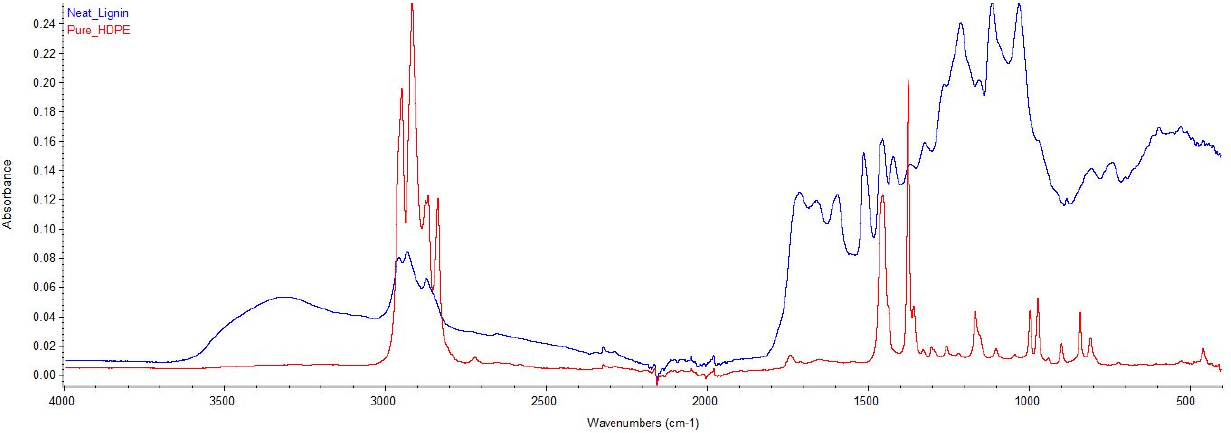
Figure 2. FTIR spectra of HDPE and lignin.